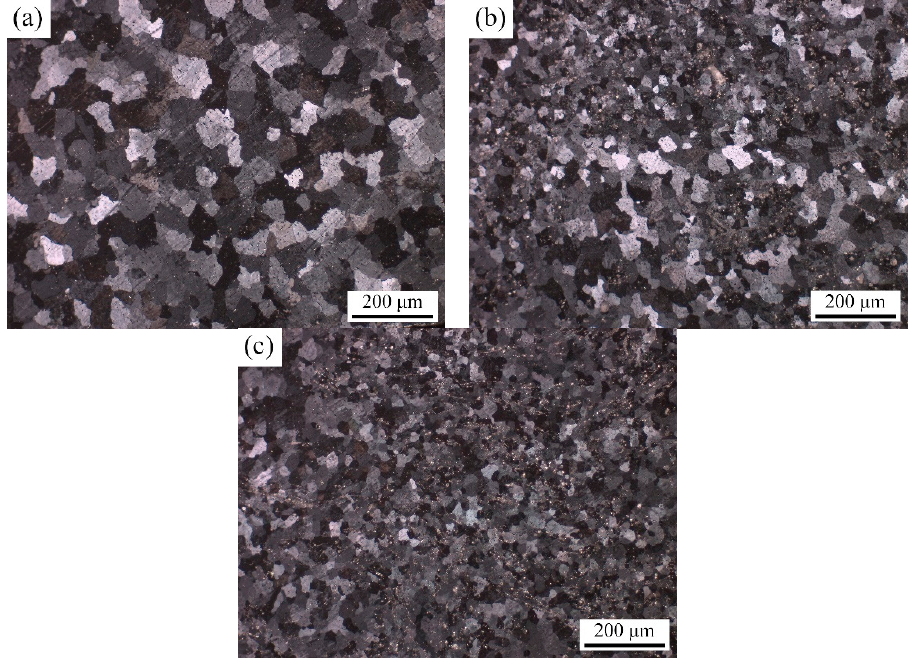
Figure 4. Optical micrographs under polarized light condition of weld joints with composite filler wires containing: ( a ) 0 wt% TiC particles; ( b ) 2 wt% TiC particles; ( c ) 4 wt% TiC particles.